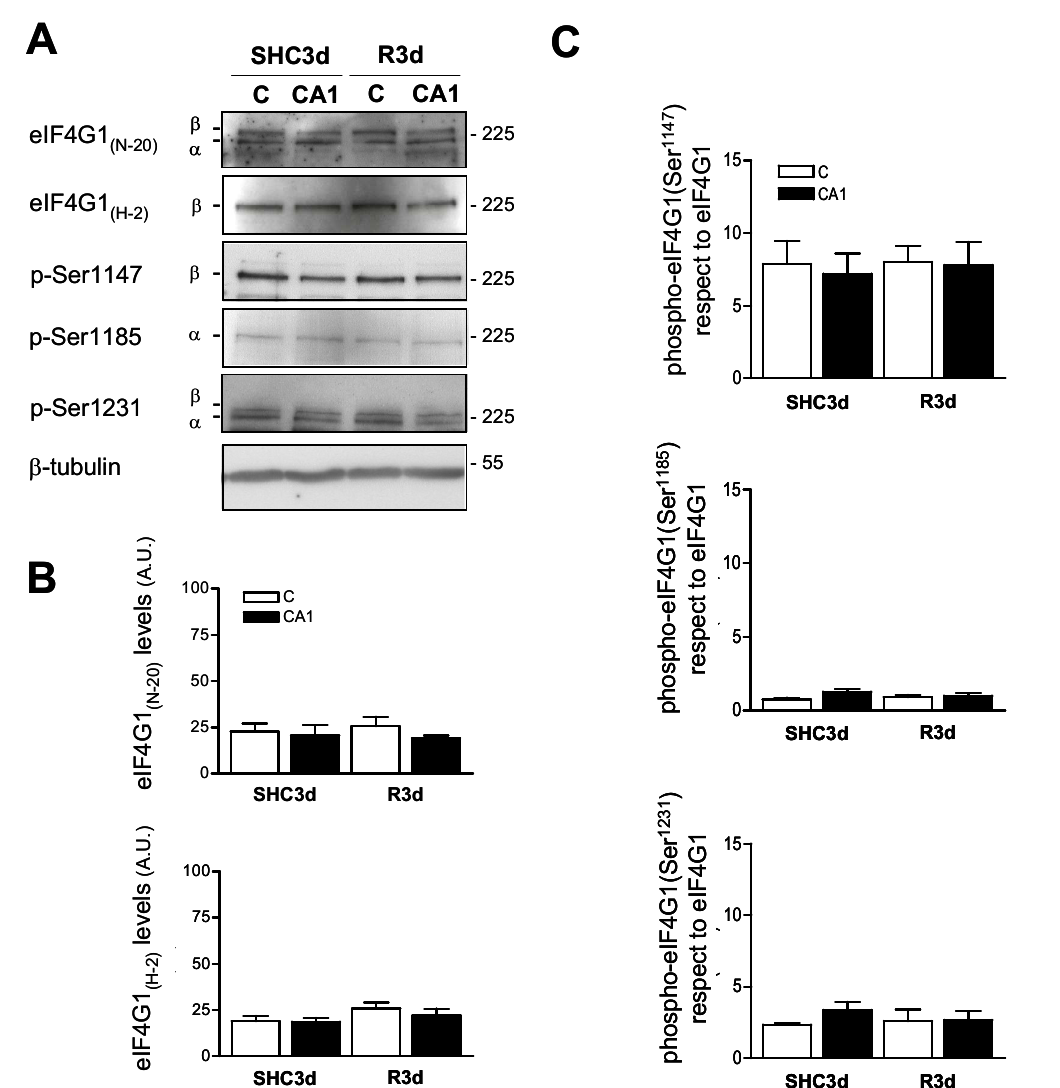
Figure 2. Identification of eIF4G1 phosphorylation sites induced by ischemia-reperfusion (IR) stress. ( A ) Samples of the cerebral cortex (C) or hippocampal CA1 region from control (SHC3d) and ischemic animals with reperfusion (R3d), were analyzed by Western blotting with anti-eIF4G1 N-20 (eIF4G1 (N-20) ), anti-eIF4G1 H-2 (eIF4G1 (H-2) ), anti-phospho-eIF4G1 Ser 1147 (p-Ser1147), anti-phospho-eIF4G1 Ser 1185 (p-Ser1185), anti-phospho-eIF4G1 Ser 1231 (p-Ser1231), and anti-β-tubulin (β-tubulin) antibodies. The α and β forms of eIF4G1 were indicated; numbers on the right indicate the apparent molecu- lar mass in kDa from protein markers. The figures are representative results of 4–6 independent experiments from 4–6 animals. Full original images of the Western blots are shown in the Supplementary Material (Figure S2) ( B ) Quantifica- tion of the eIF4G1 levels in Western blots using eIF4G1 N-20 (upper) or eIF4G1 H-2 (lower) antibodies. ( C ) Quantification of eIF4G1 phosphorylated (phospho-eIF4G1) at Ser 1147 , Ser 1185 and Ser 1231 residues with respect to total eIF4G1 levels (ratios) detected with anti–eIF4G1 (N-20) antibody. Bar graphs represent the mean of 4–6 independent experiments from 4–6 ani- mals; error bars indicate SE. No statistical significance was found.